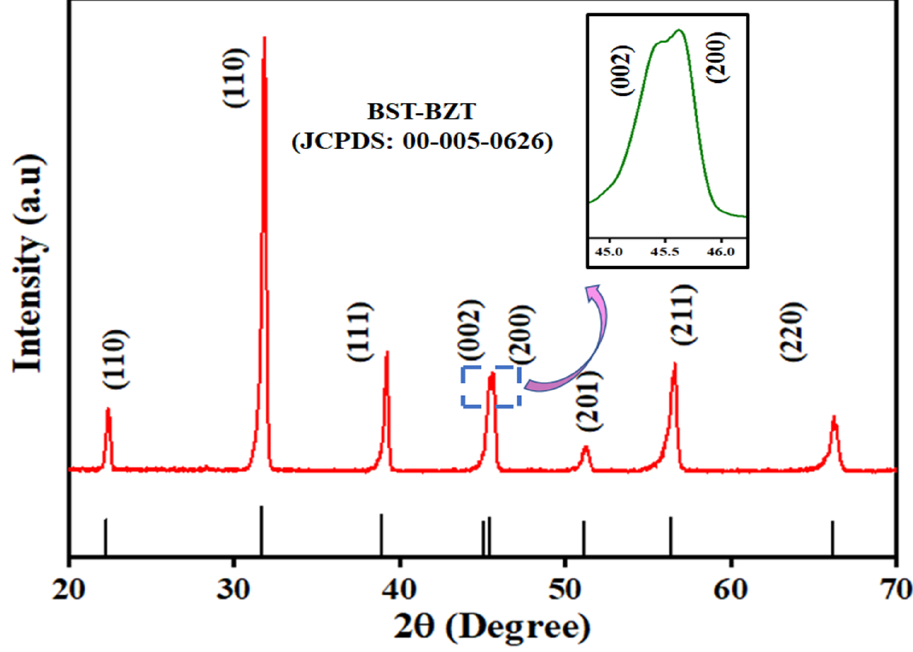
Figure 2. XRD pattern of BST ‒ BZT ceramic powder .